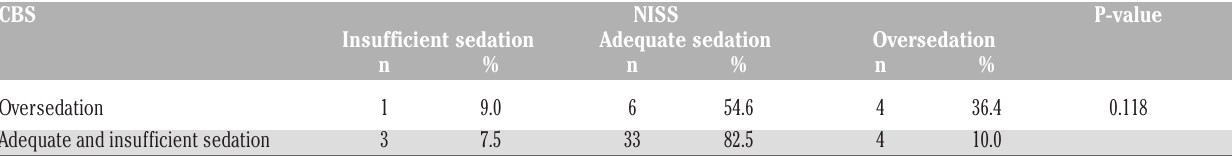
Table 3. Concurrent validity of CBS compared to NISS (N= 51).